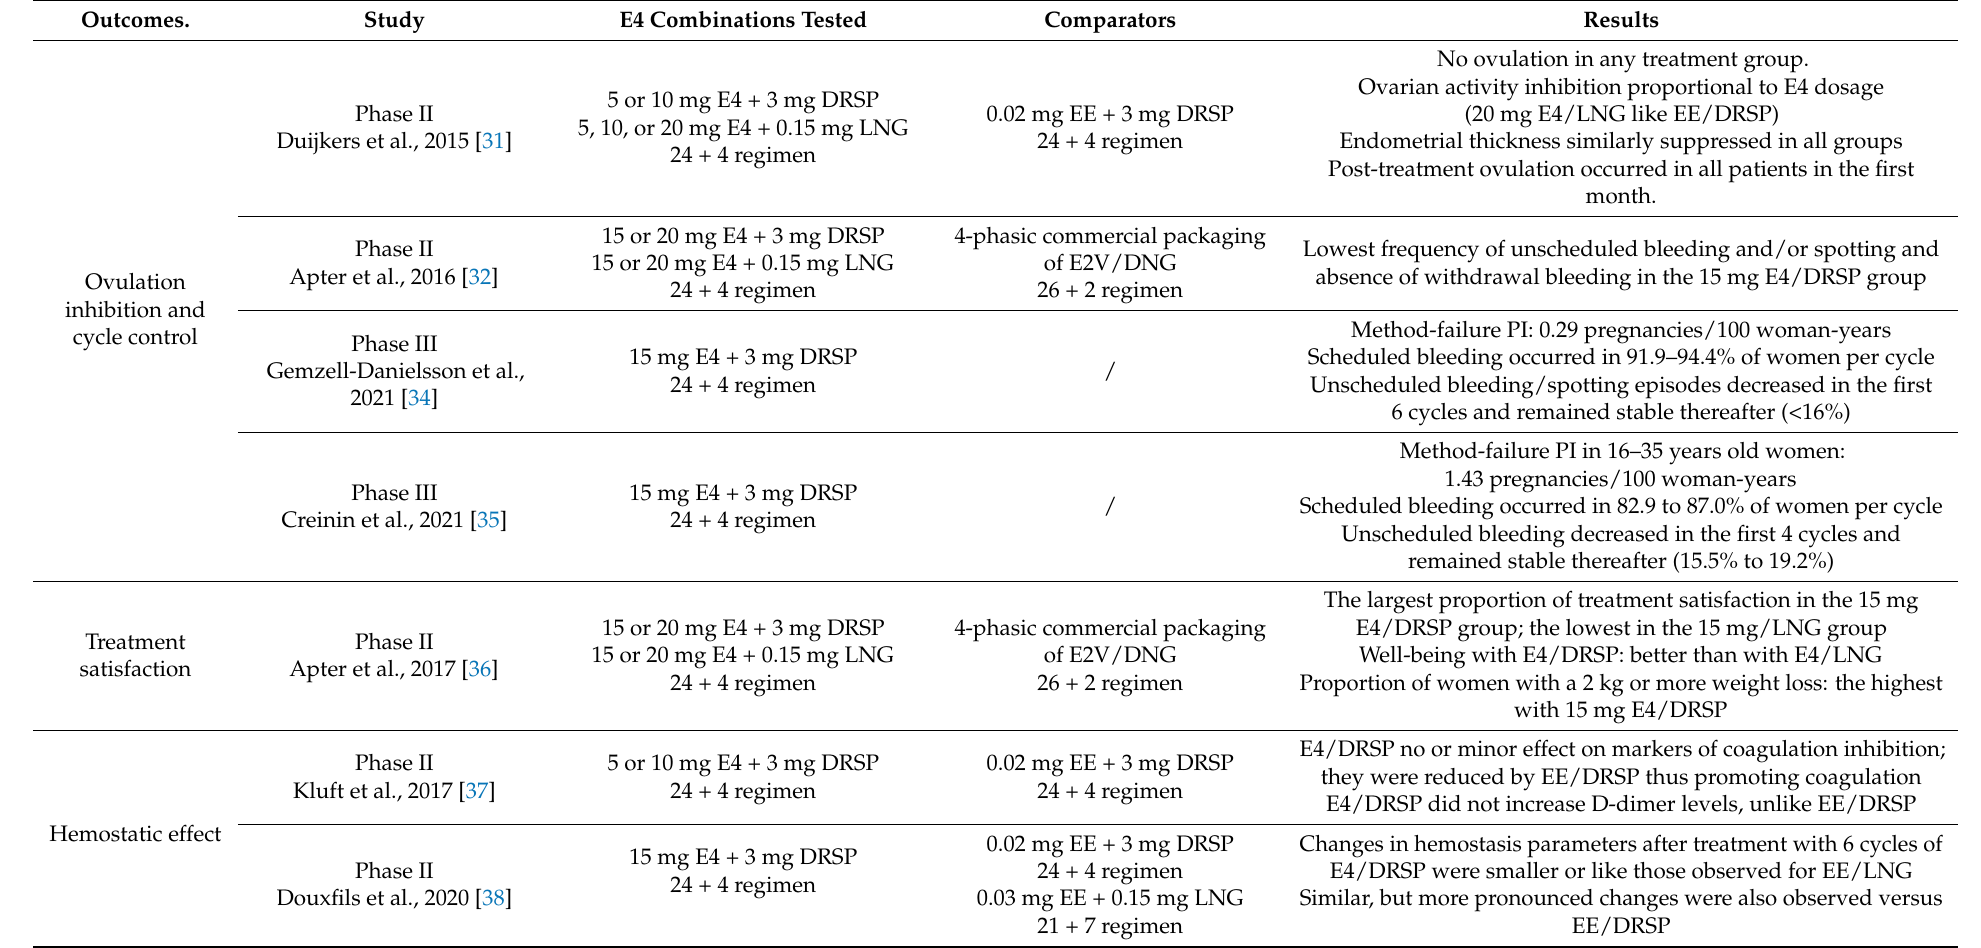
Table 2. Phase II and phase III studies about new estetrol (E4)-containing combined oral contraceptives (COCs) are summarized. Studies are divided according to the outcomes studied.